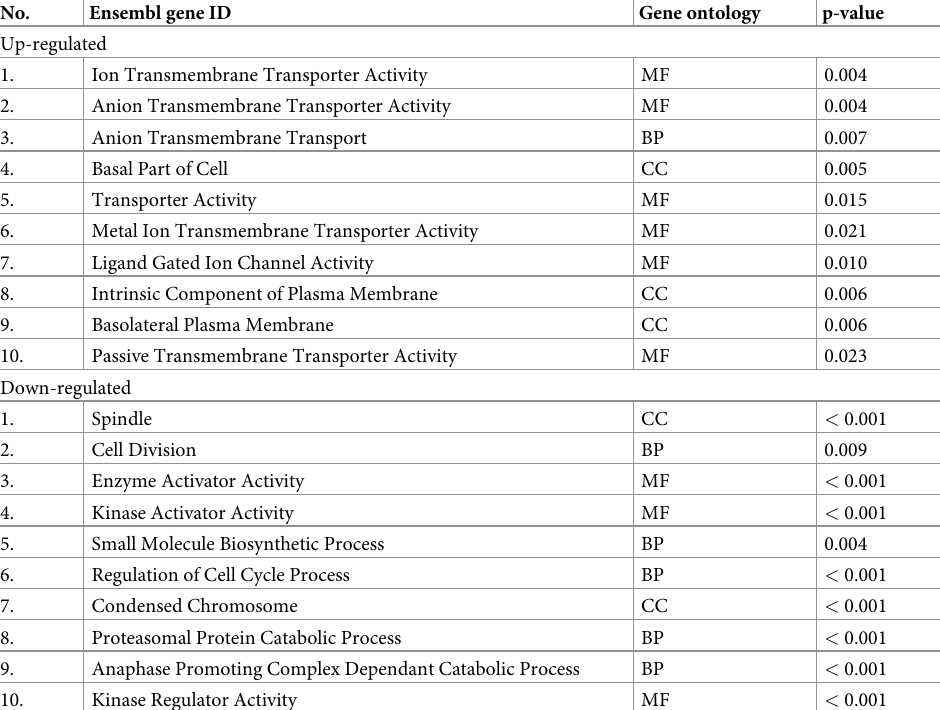
Table 3. Top 10 significant GO terms (up and down-regulated) when comparing the gene expression of MOL- treated hWJMSCs and untreated hWJMSCs (control). No.